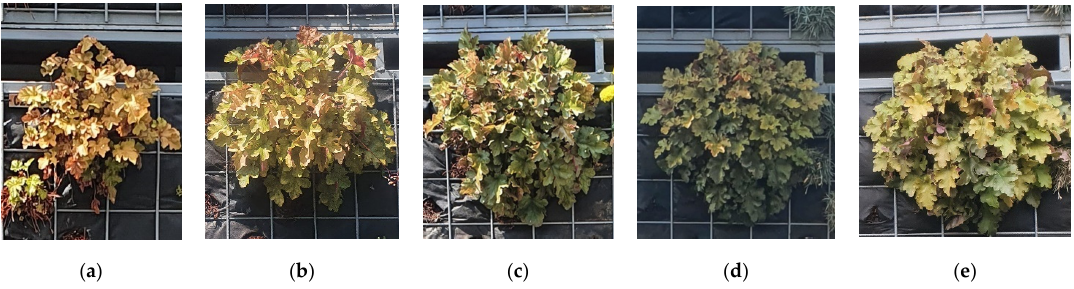
Figure 13. Heuchera x hybrida ‘Marmalade’ May–December 2020, level 3, eastern facade. ( a ) May; ( b ) June; ( c ) August; ( d ) October; and ( e ) December.